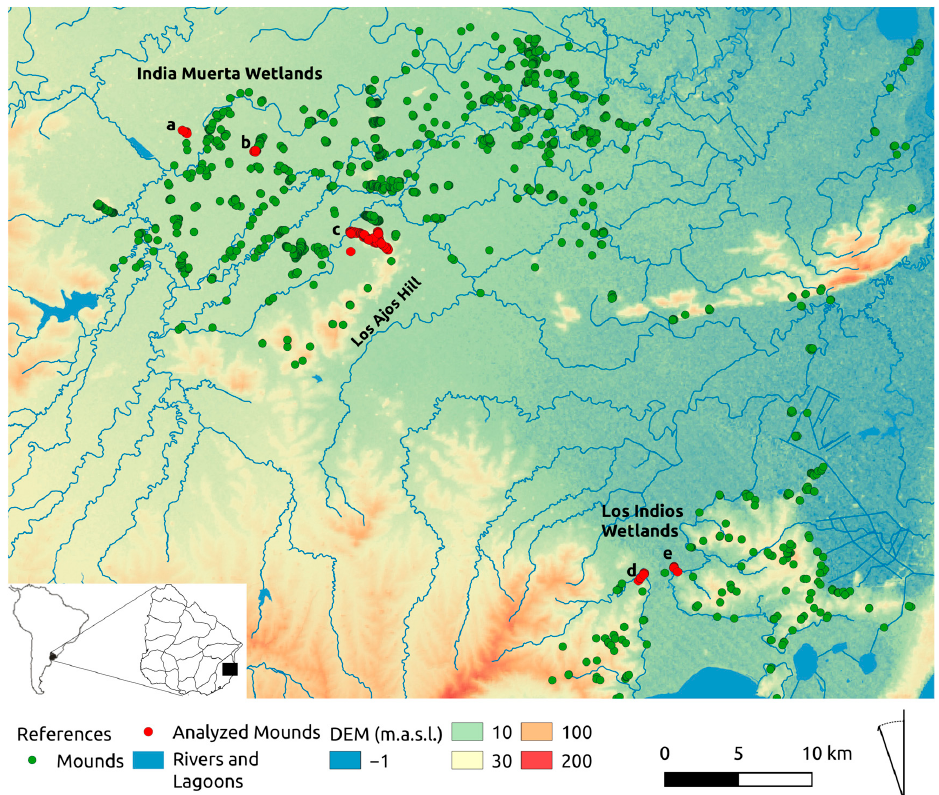
Figure 1. Distribution of georeferenced mound sites in the study areas and location of mound sites analyzed. a, García Ricci; b, Los Talitas; c, Los Ajos; d, Los Indios B and e, Los Indios